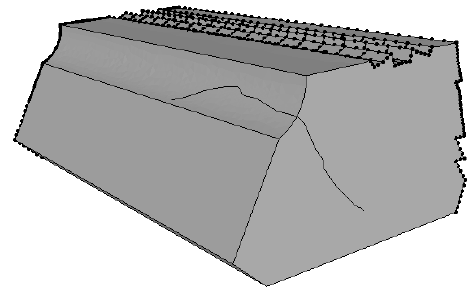
Figure 13. The 30 ◦ angle, long flank crack shape. Figure 13. The 30° angle, long flank crack shape. Figure 13. The 30° angle, long flank crack shape.